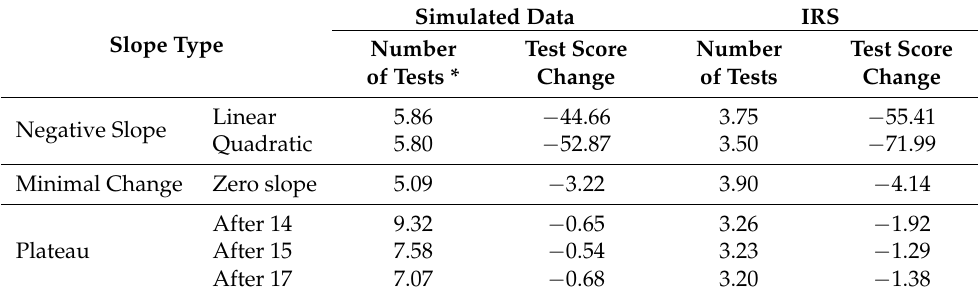
Table 3. Results of the simulation study for the sparse-data